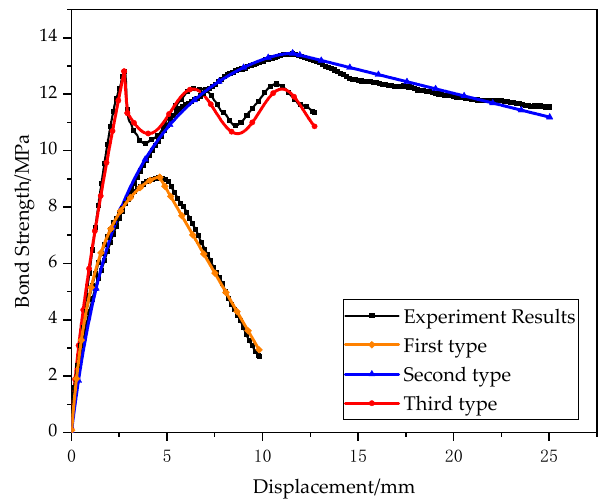
Figure 14. Comparison of fitted bond-slip curves and test results. Table 6. Parameters adopted in Figure 13.